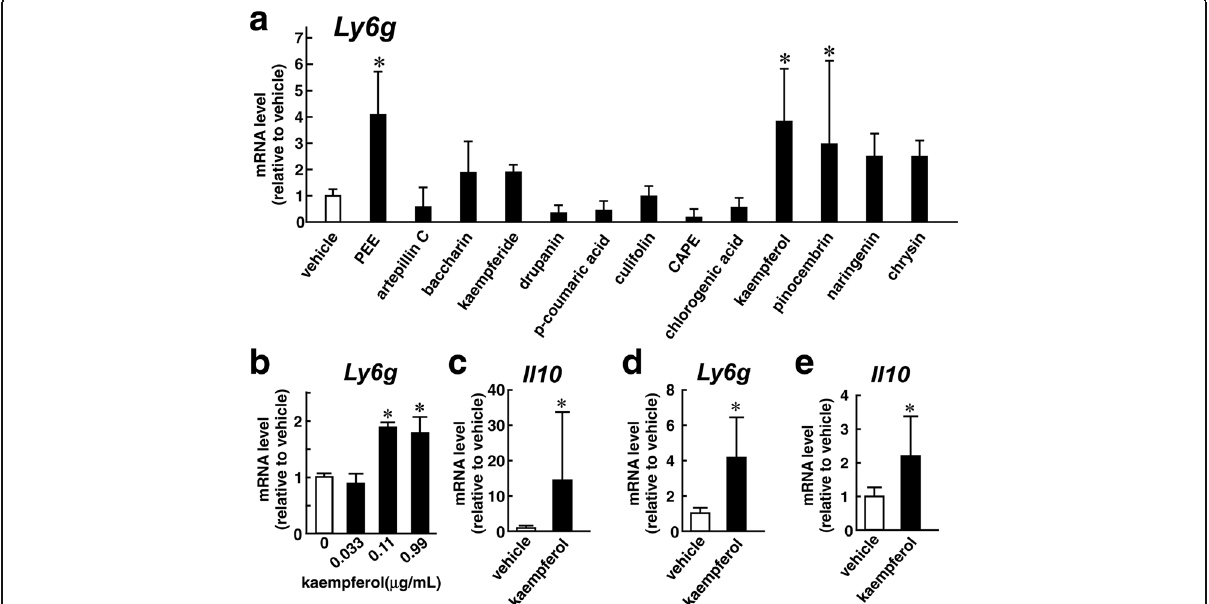
Fig. 6 Effects of resinous compounds on the expression of MDSC markers in cultured macrophages. a - c Thioglycolate-elicited macrophages or ( d , e ) J774.1 cells were treated with vehicle, PEE (100 μ g/mL), or twelve resinous compounds involved in PEE for 24 h and subsequently subjected to qRT-PCR analysis. a Comparisons of the effects of the compounds on Ly6g expression. Doses of each compound are described in the Results. b - e Effects of kaempferol ( b , 0.03, 0.1, or 1 μ g/mL; c - e , 0.1 μ g/mL) on ( b , d ) Ly6g and ( c , e ) Il10 expression in ( b , c ) peritoneal macrophages and